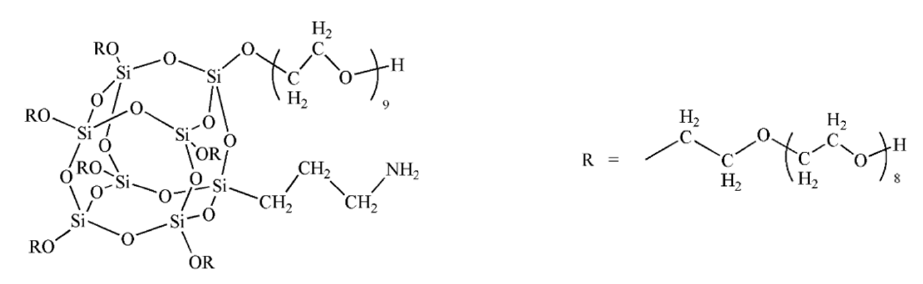
Figure 1. FTIR spectra of PEO (1), TEOS (2), AGM (3), PEOASiP (4), ASiP–AGM-10 (5), ASiP–AGM-50 (6), ASiP–AGM-80 (7) and ASiP–AGM-100 (8).